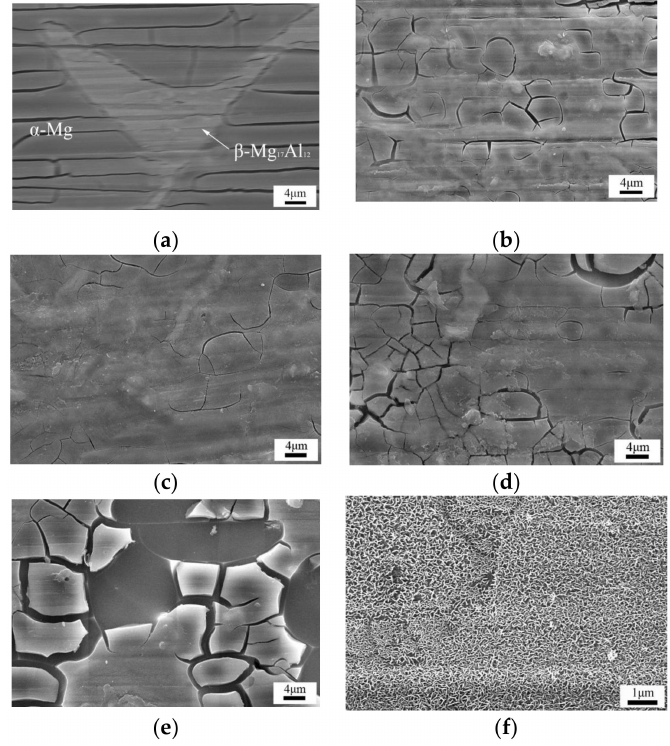
Figure 2. Surface morphologies of the LDHs coatings at different formation times; ( a ) 10 min, ( b ) 20 min,